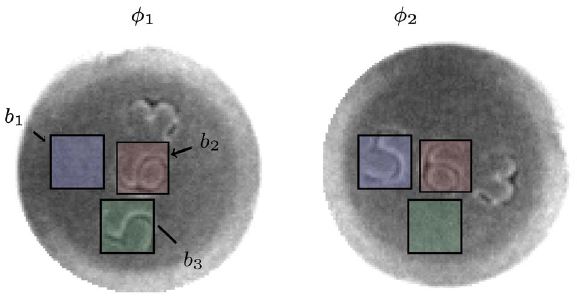
Figure 7. Set of blocks is equal for all rotation angles W . Each block contains relevant information, i.e., imprint, only at certain angles.